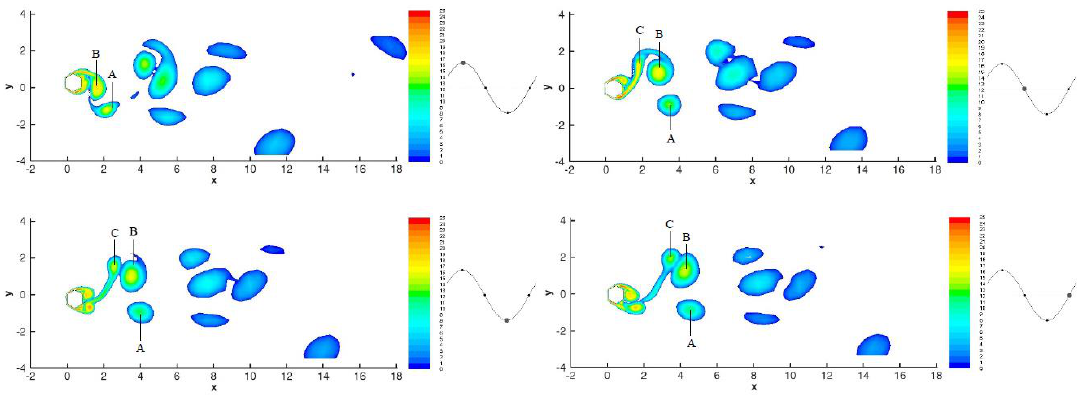
Figure 11. Vorticity contours at four instants in a vibration period of the face-oriented hexagonal cylinder at Vr = 10 at 21.32 < t* < 21.92.